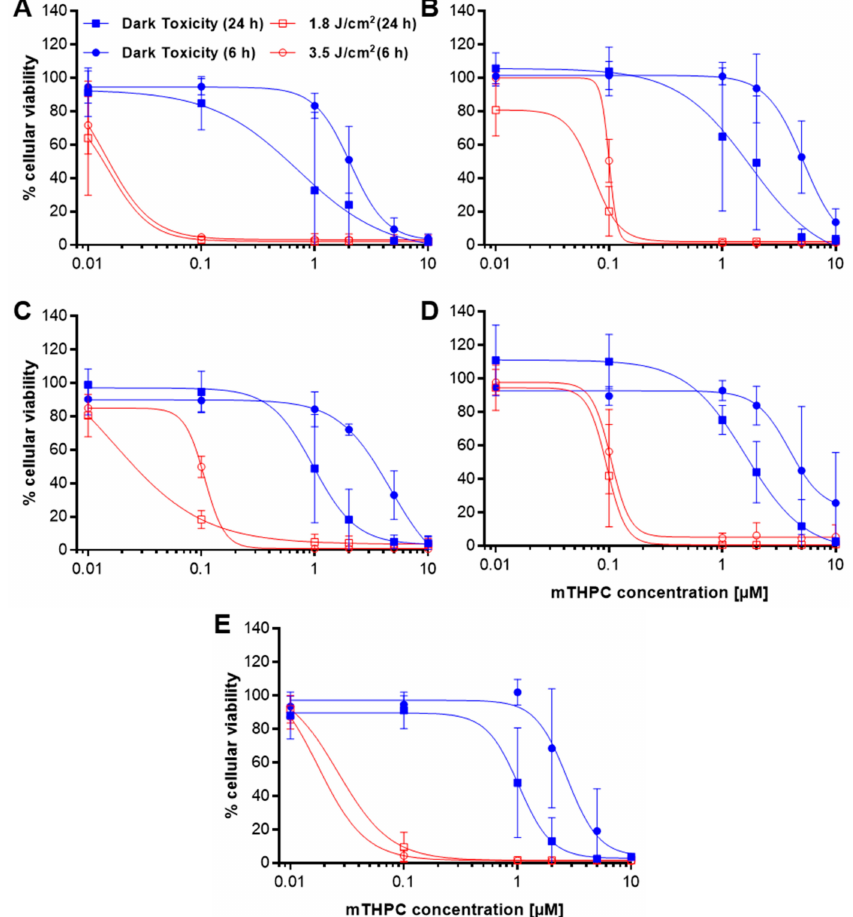
Figure A5. Dark ( (cid:8) , 6 h; (cid:4) , 24 h) and light-induced ( treatment as assessed by the MTT viability assay (with remaining cells from LDH release